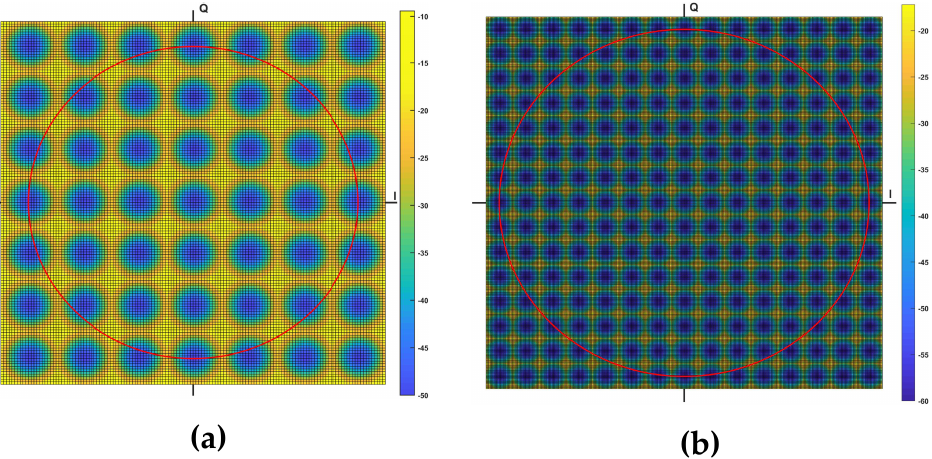
Figure 10. The output of η distribution when ( a ) M = 2 and ( b ) M =